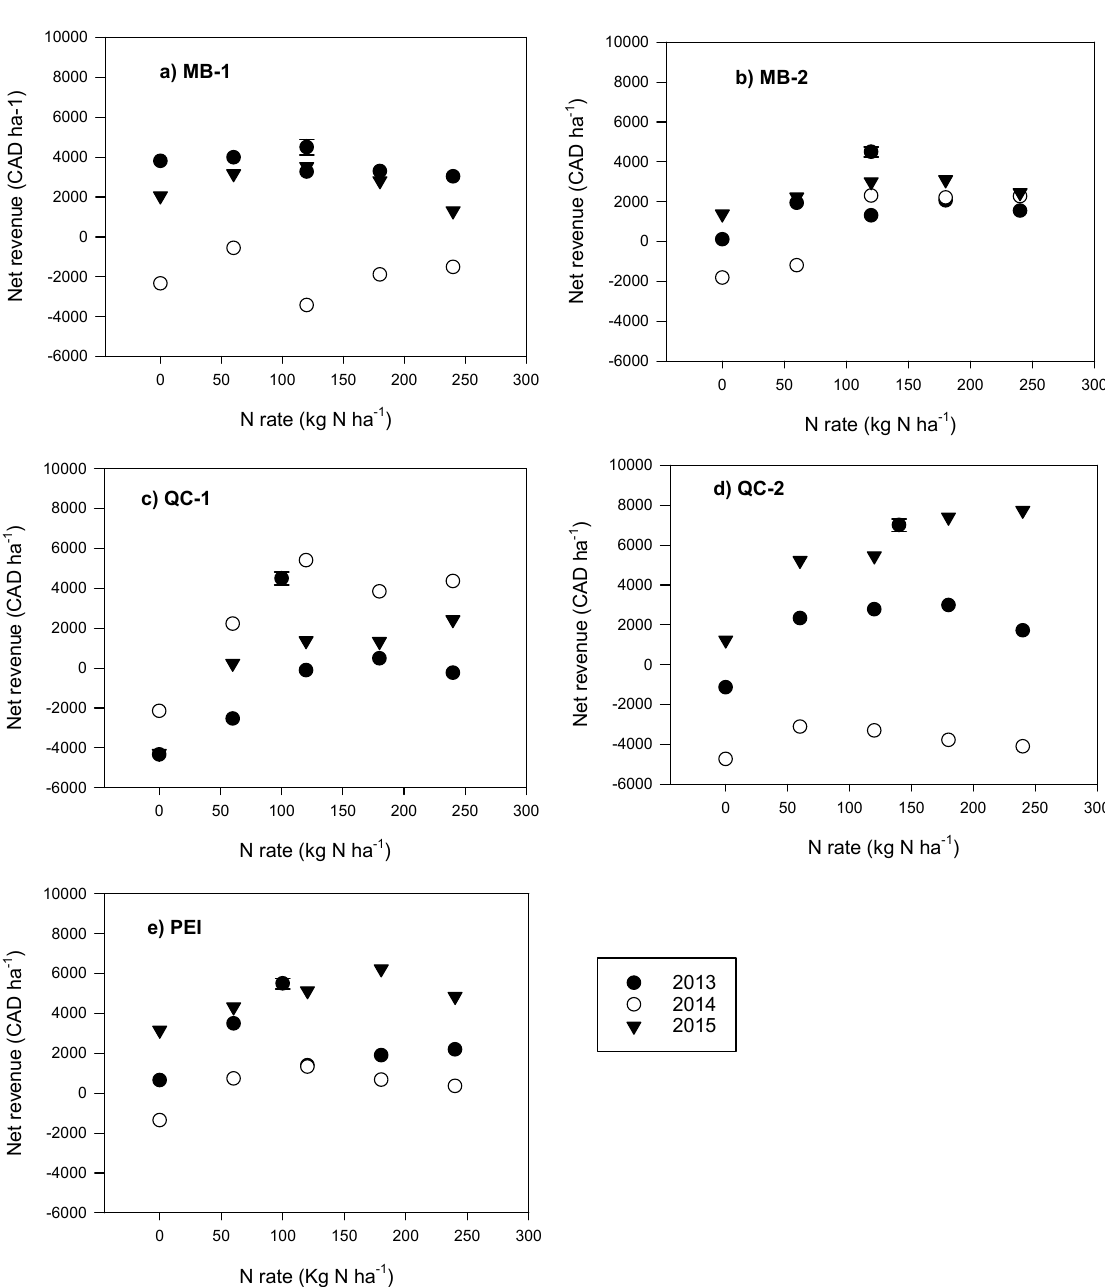
Figure 2. Net revenue versus N rate at: MB-1 ( a ), MB-2 ( b ), QC-1 ( c ), QC-2 ( d ), and PEI ( e ) in 2013, 2014, and 2015. Vertical bars represent the standard errors of the mean.